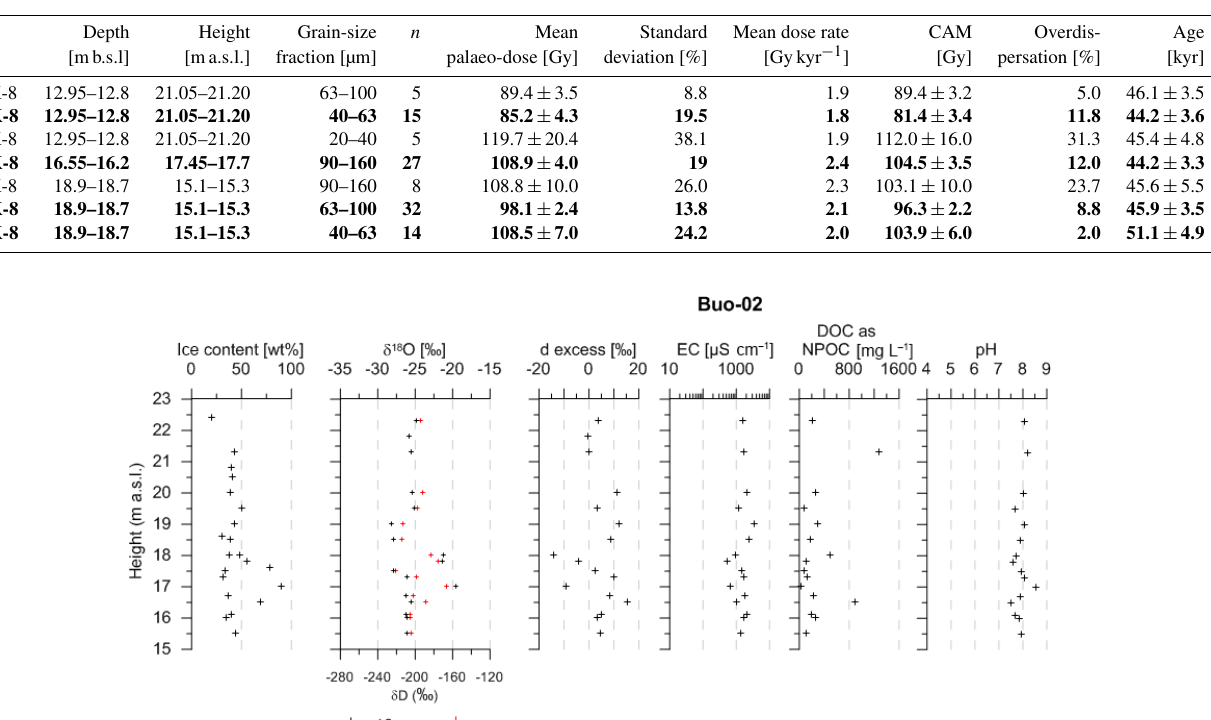
Table 3. Results of IRSL dating from three BK-8 core samples using different feldspar grains on 4mm aliquots ( n : number of aliquots; CAM: central age model; see Galbraith et al., 1999), samples with interpreted age information are highlighted in bold.